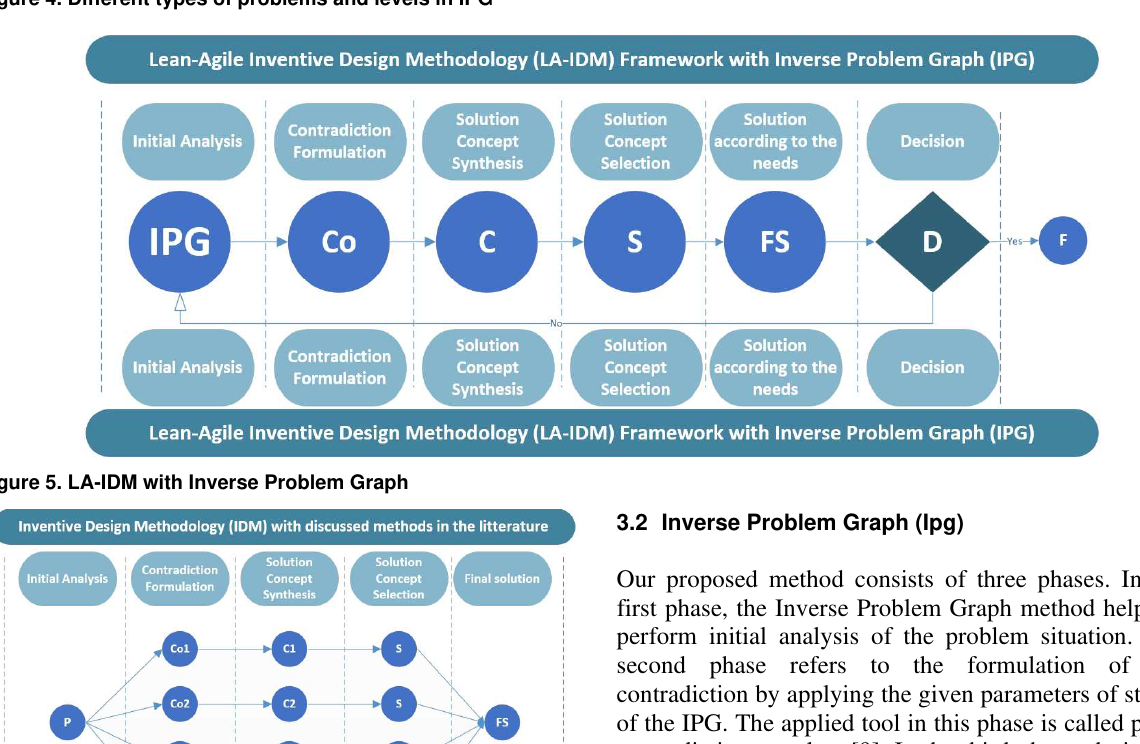
Figure 4. Different types of problems and levels in IPG